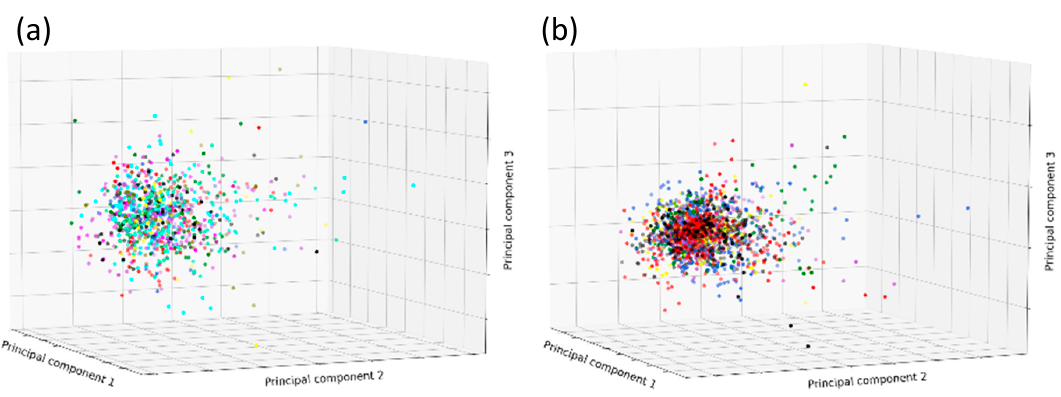
Figure 3. Principal Component Analysis (PCA) analysis seven molecular descriptors for the groups of ligands on the base of protein families in Table 2. The PCA analysis of ligands from the protein families were split into two groups according to the same division on Figure 1b ( a ) and Figure 2b ( b ). The descriptors used in the analysis are weight, rotatable bonds, hydrogen bond acceptor, hydrogen bond donor, clogP, total polar surface area, and van der Waals volume.